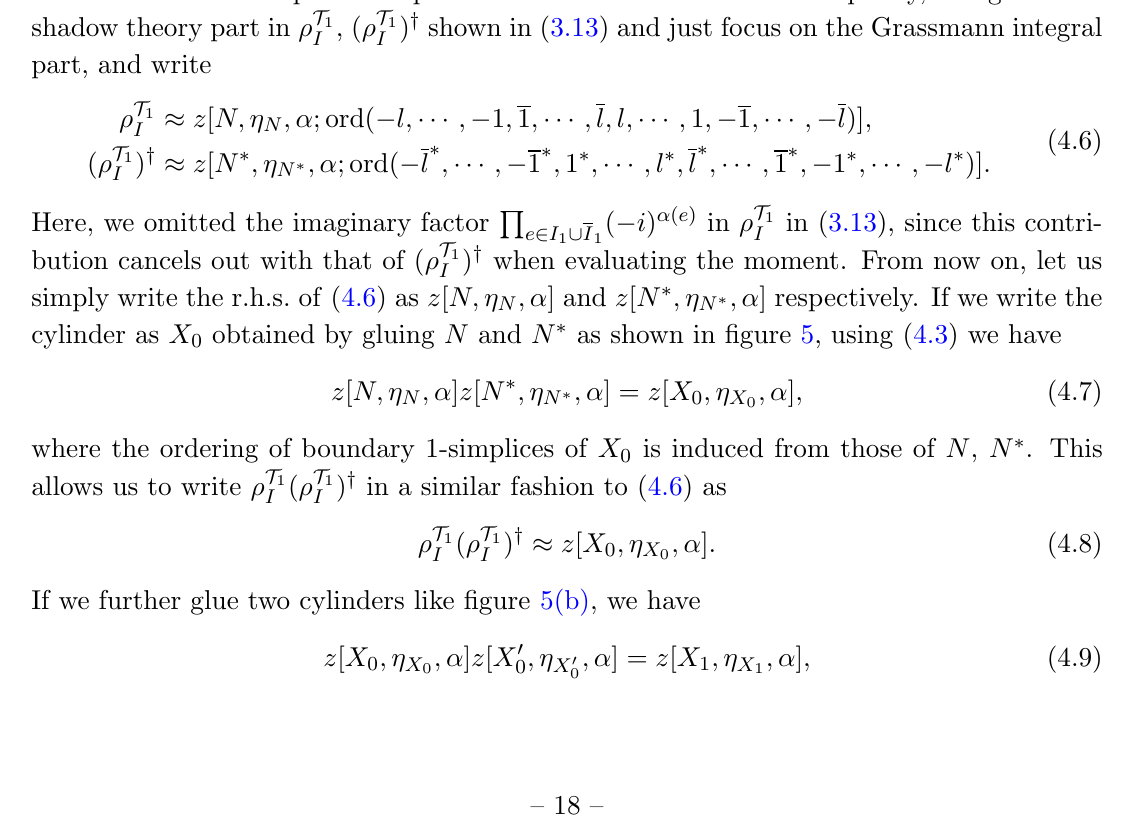
Figure 5 . (a): the computation of (cid:26) T 1 (cid:26) T 1 ( (cid:26) T 1 ) y (cid:26) T 1 ( (cid:26) T 1 ) y gives a path integral on a torus with two I I I I